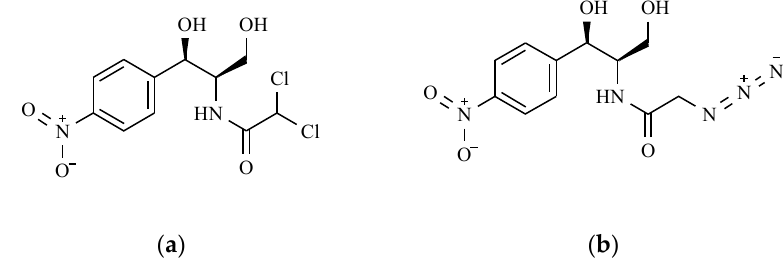
Figure 12. The chemical structure of chloramphenicol ( a ) and its derivative—azidamphenicol ( b ).